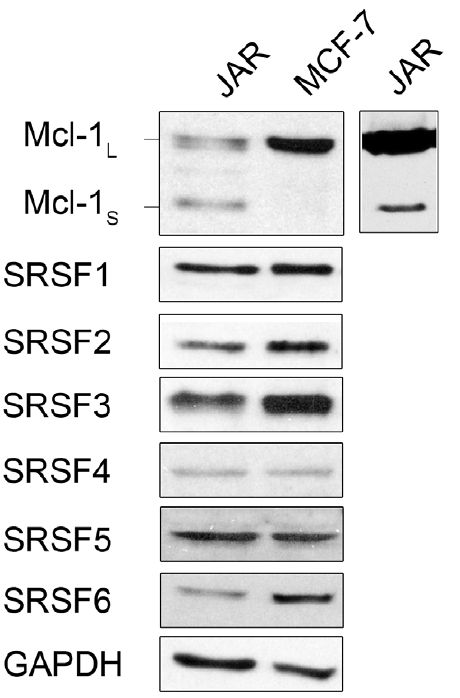
Figure 2. Expression of Mcl-1 and SR proteins in MCF-7 and JAR cells. Top panel shows Mcl splice isoforms in commercially available JAR cell lysate, MCF-7 cells and JAR cells. Detection by western blotting of Mcl-1 splice variants, SRSF1-6 and the loading control GAPDH in 40 ug of total cell lysate from MCF-7 and JAR cells.